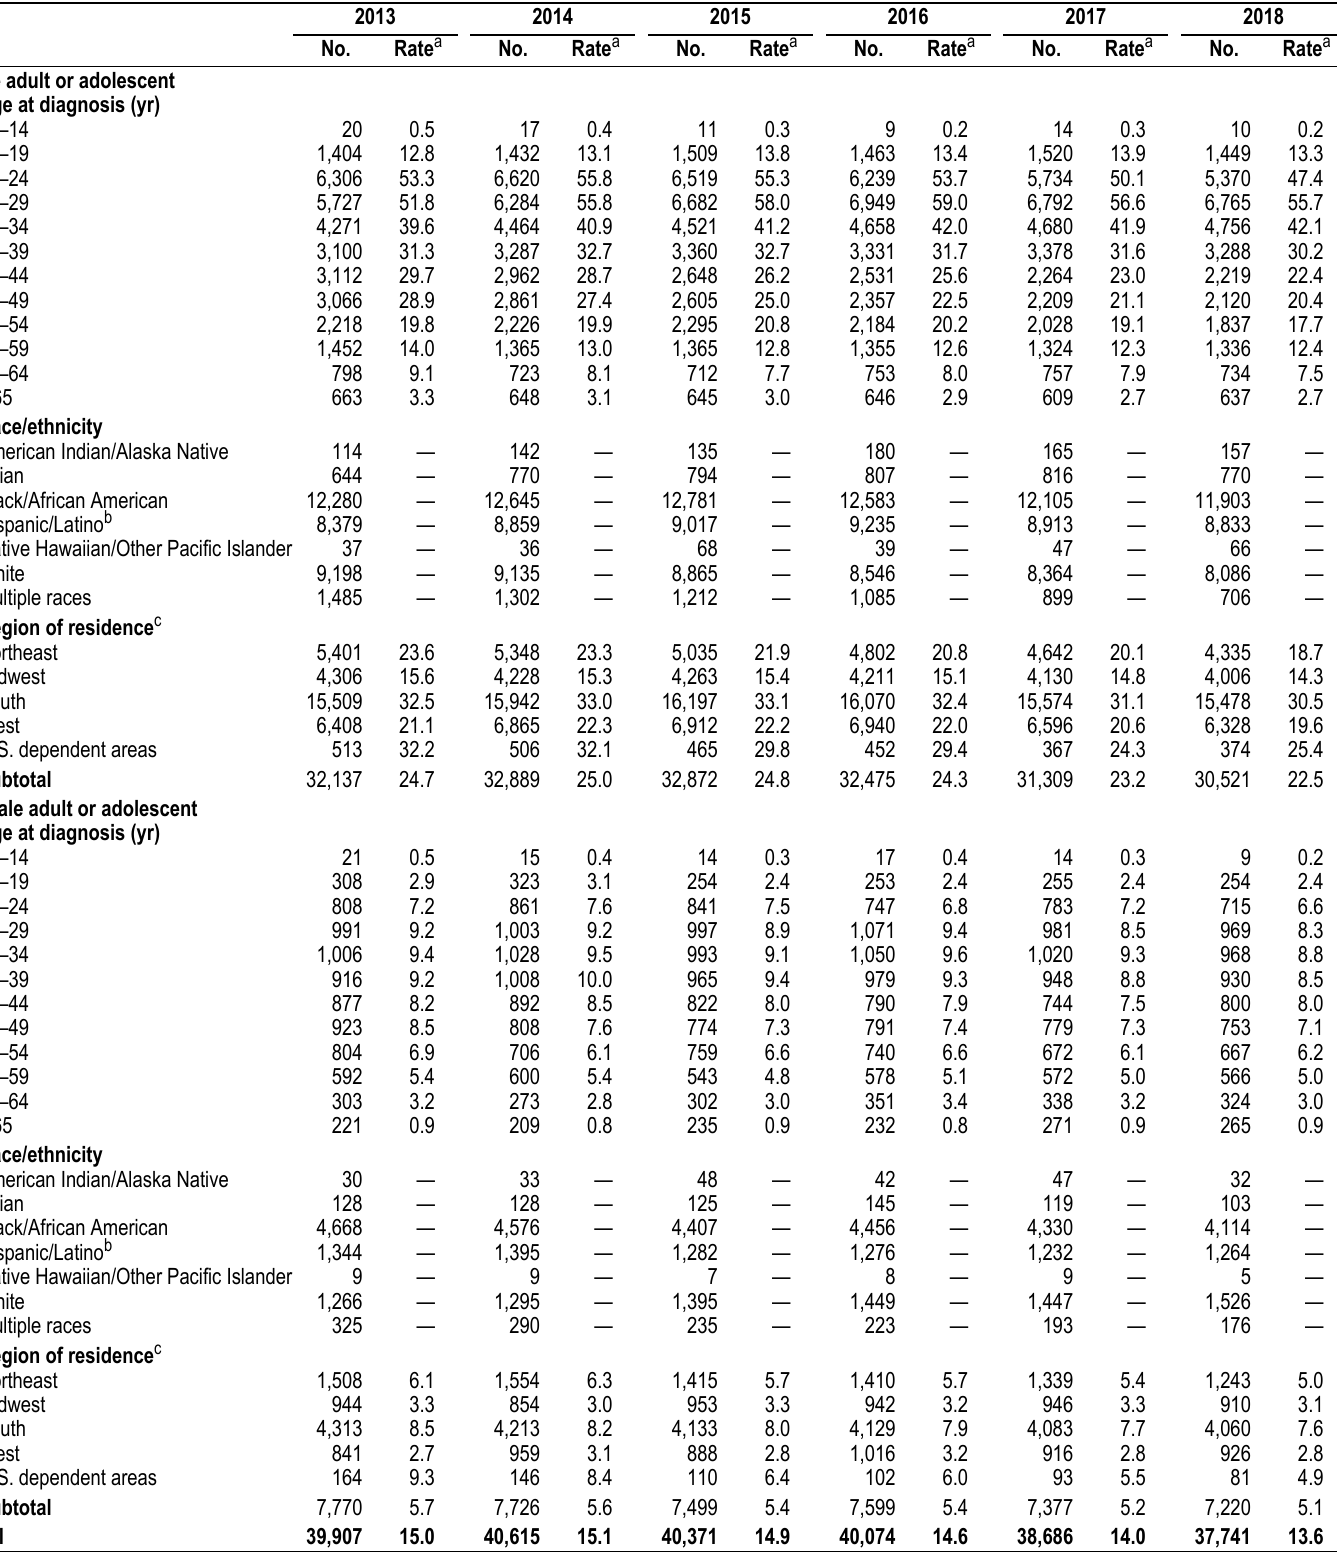
Table 5b. Diagnoses of HIV infection among adults and adolescents, by year of diagnosis, sex, and selected characteristics, 2013–2018— United States and 6 dependent